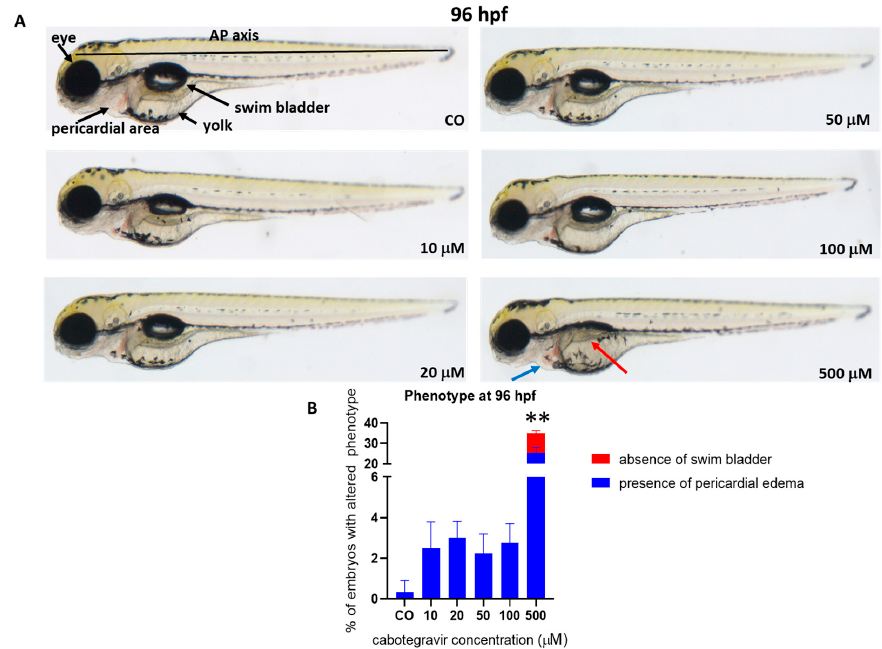
Figure 2. Representative pictures at 96 h post fertilization (hpf) of the gross morphological effects on zebrafish embryos of cabotegravir (CAB) exposure by the immersion method. ( A ) Dechorionated embryos were exposed by the immersion method to different CAB doses from gastrula stage (4 hpf) up to 96 hpf as time endpoint for morphology observations. CAB was dissolved in fish water containing 0.1% dimethyl sulfoxide, DMSO. Control embryos [CO] were treated with fish water and 0.1% solvent (DMSO). All treatments including controls were conducted three times, with 30 embryos for each experiment and each treatment. Embryos in the figures are representative of all ex- periments. All pictures are lateral views with dorsal to the top and anterior to the left. The red arrow indicates the absence of an inflated swim bladder, and the blue arrow indicates the presence of per- icardial edema. ( B ) Percentages of embryos with defects. Results are expressed as mean ± SD of three independent experiments, with 30 embryos for each experiment and each treatment. (** p < 0.005 vs. control group).